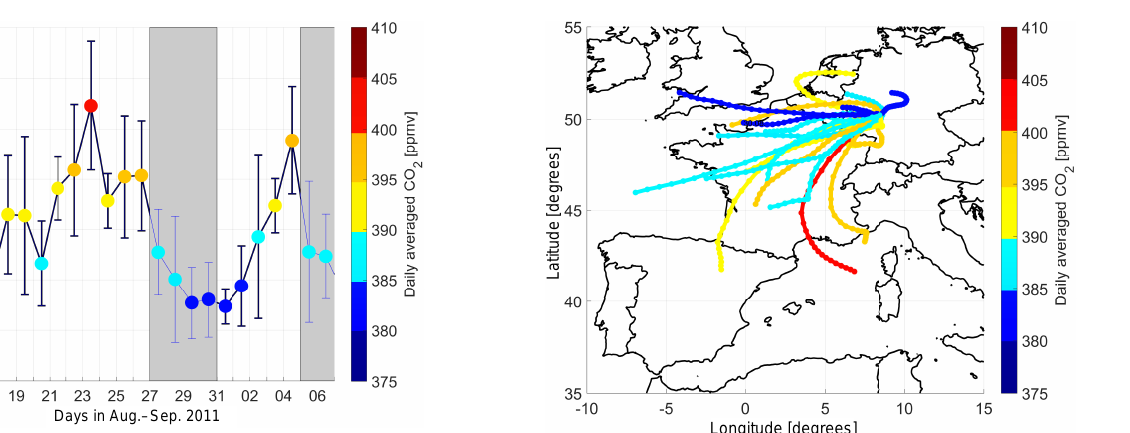
Figure 3. Backward trajectories, starting from the Mount Kleiner Feldberg at 200m altitude over the surface for each day at 12:00UTC up to 24h based on wind fields from COSMO-7. The colours represent the daily averages of CO 2 measurements from Mount Kleiner Feldberg (Fig. 2).